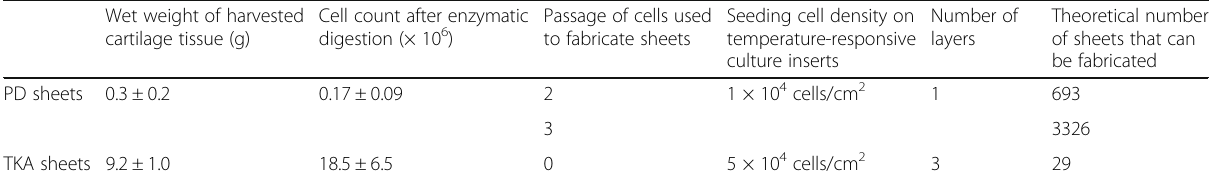
Table 1 Theoretical number of chondrocyte sheets that can be fabricated from the collected cartilage tissue Wet weight of harvested Cell count after enzymatic cartilage tissue (g) digestion (× 10 6